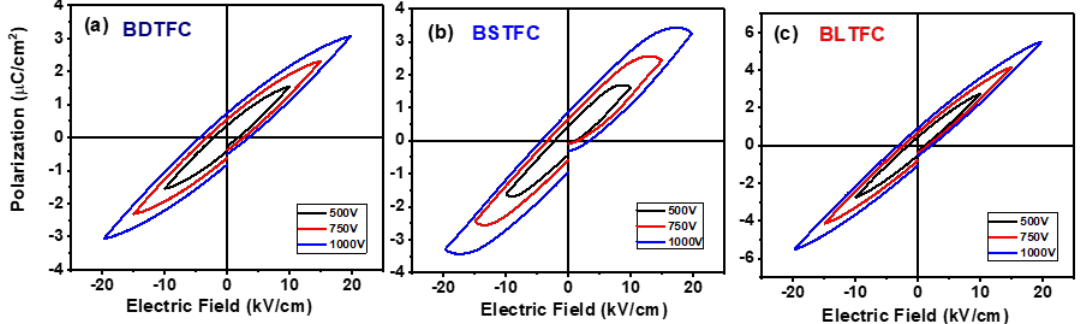
Figure 5. ( a − c ) Ferroelectric hysteresis loops (P vs E curves) of BDTFC, BSTFC, and BLTFC samples. Figure 5. ( a – c ) Ferroelectric hysteresis loops (P vs. E curves) of BDTFC, BSTFC, and BLTFC